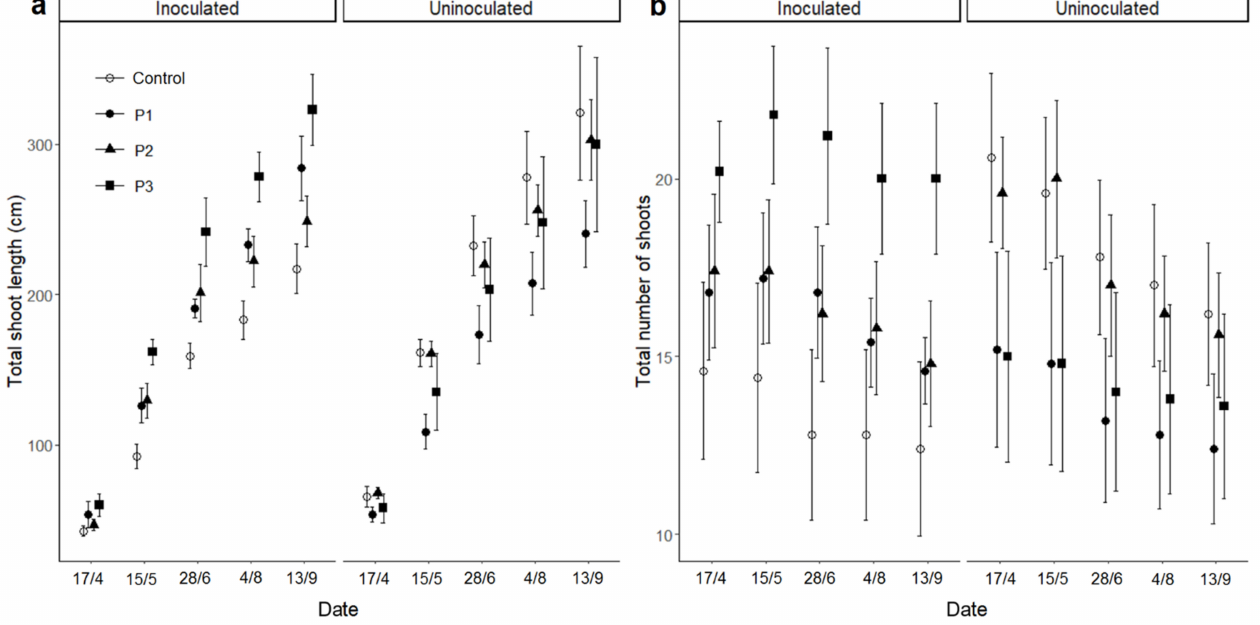
Figure 2. The average total shoot length (cm, ( a )) and total number of shoots ( b ) of inoculated and uninoculated Ajania plants treated with different phosphorus levels (P1, P2 and P3) and without phosphorus (control) in 2016. The vertical bars represent ± SE of the mean value (n =